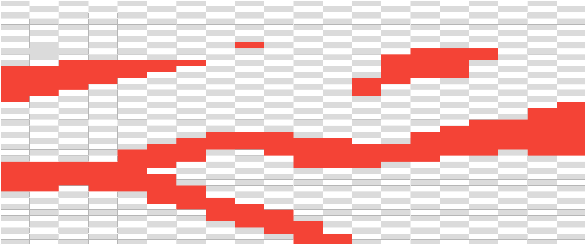
Figure 21. Grid 20 × 41 (automatic).